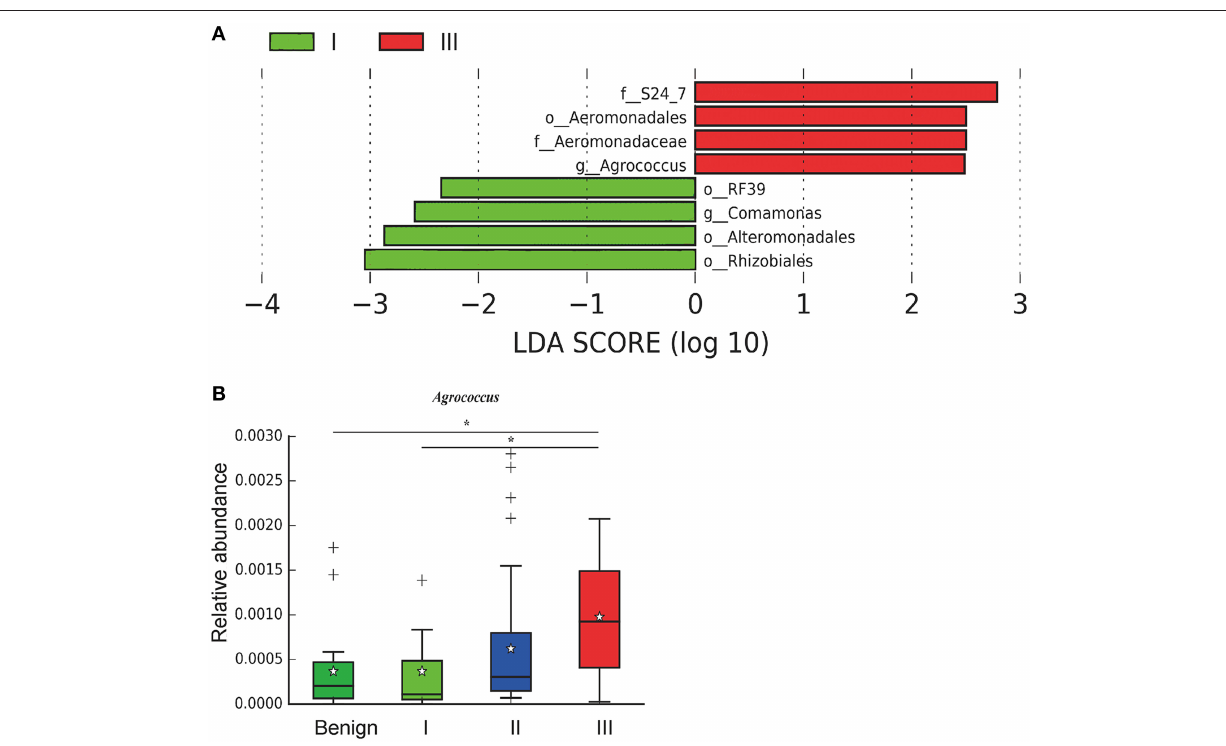
FIGURE 7 | LefSe identified the most differential microbiota in benign, grade I, II, and III. (A) Histogram of the LDA scores computed for different abundant in benign, grade I, II, and III. Grade I is indicated with a negative LDA score, and malignant have a positive score. The LDA score indicates the effect size and ranking of each differentially abundant taxon. (B) Boxplot compares the relative abundance of Agrococcus between different grades of breast tumor tissue ( P = 0.021, Kruskal-Wilcox’s H -test). * indicates that grade I and grade III are significantly different ( P = 0.049, Welch’s t -test), benign and grade III are significantly different ( P = 0.011, Welch’s t